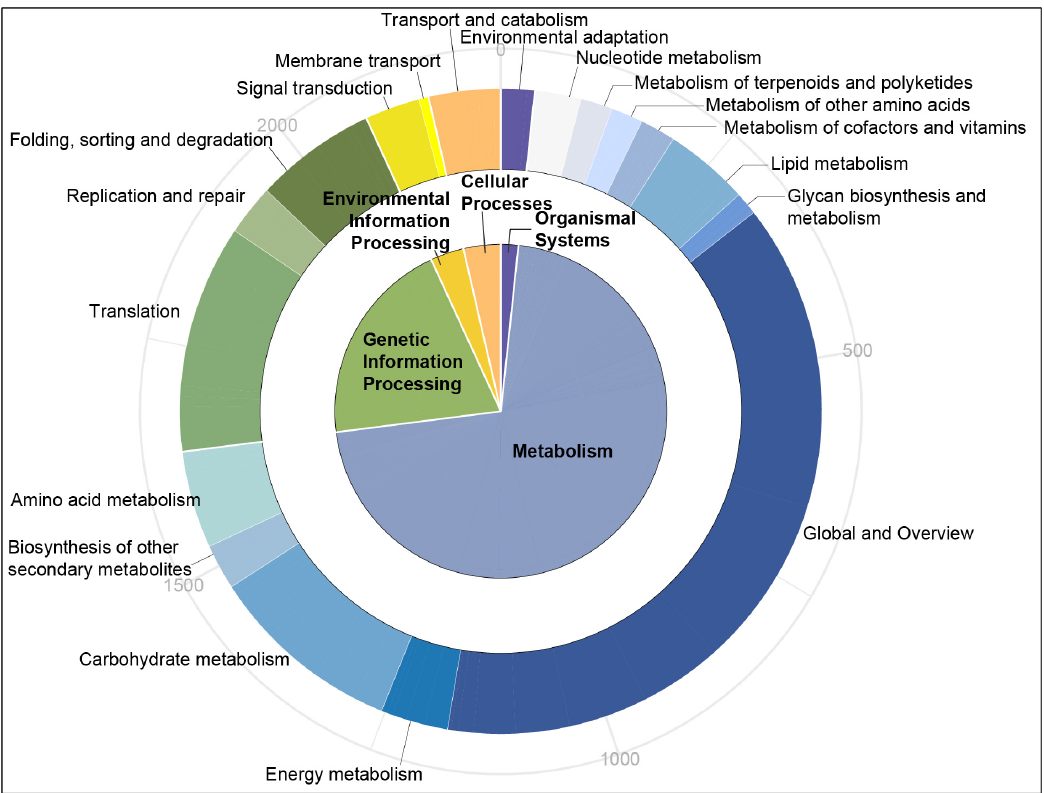
Figure 3. Kyoto Encyclopedia of Genes and Genomes (KEGG) pathway annotation of unigenes with embedded SSRs. The numbers outside the circle represent the cumulative number of unigenes beginning at zero and moving in a clockwise manner.